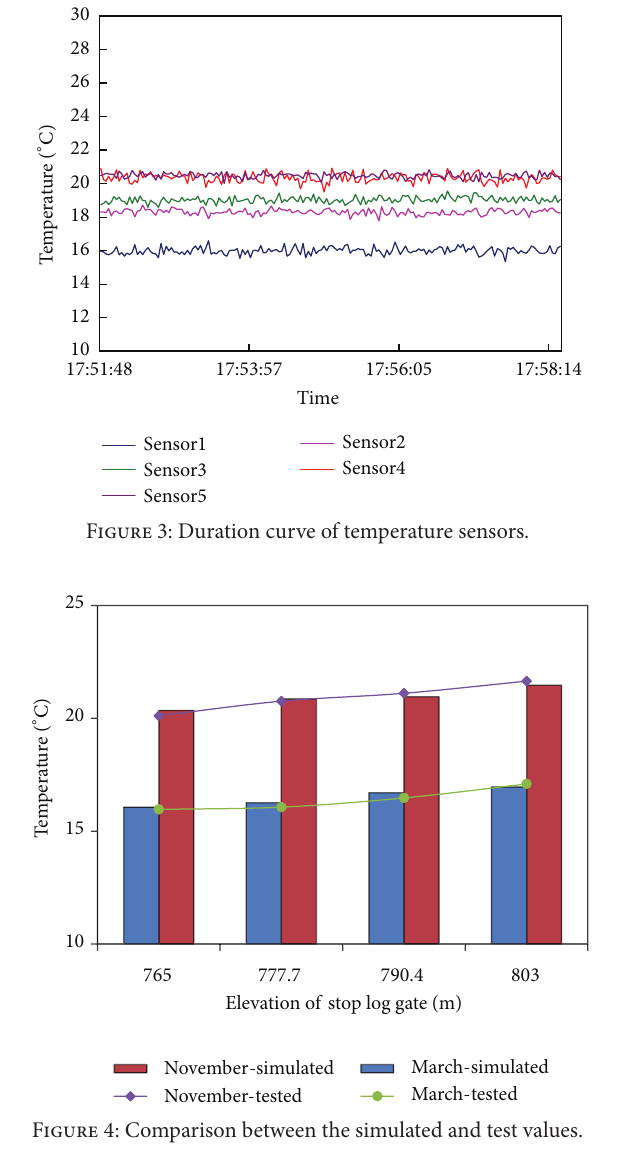
elevation was reached, the gradient began to decrease. The temperature differences in May and October were 15 ∘ C, respectively. 10